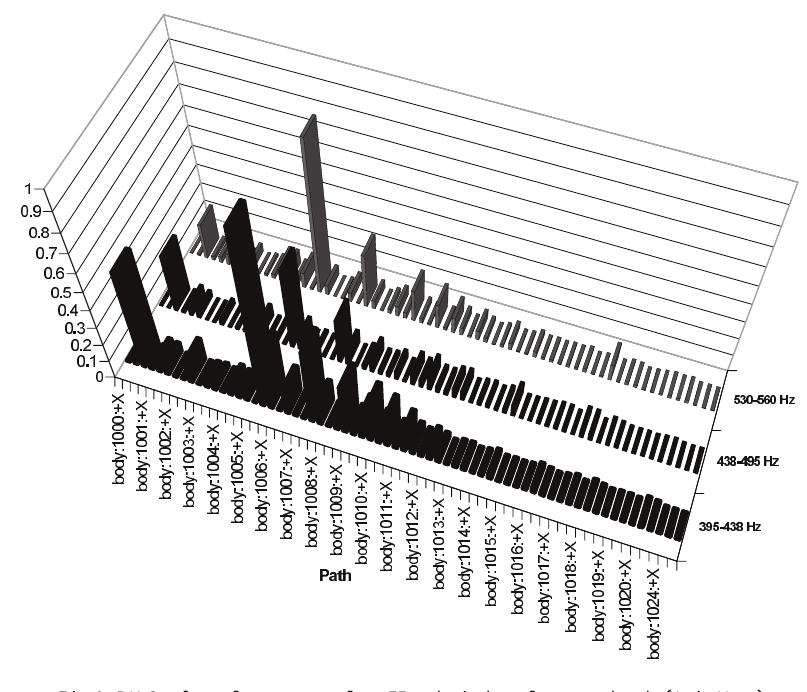
Fig. 9. RMS values of power flows from 75 paths in three frequency bands (Unit: Watt).